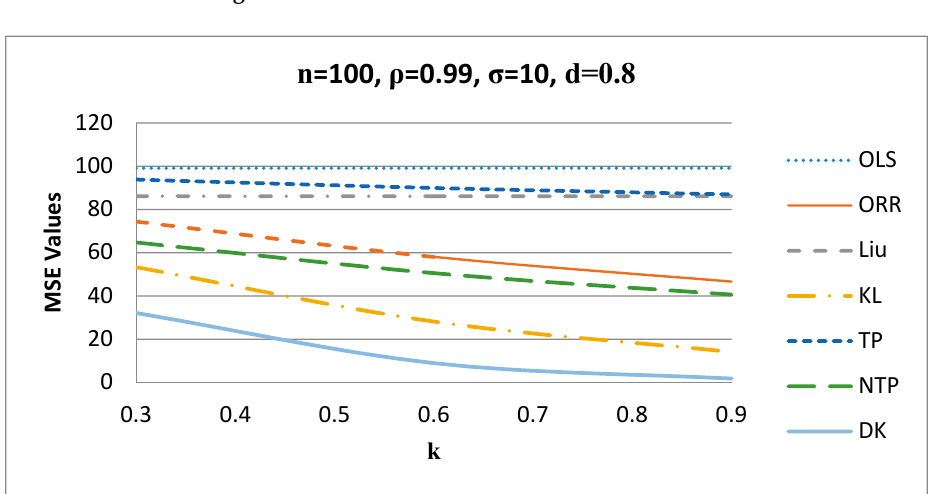
Figure 5. MSE values versus k values when d = 0.5.